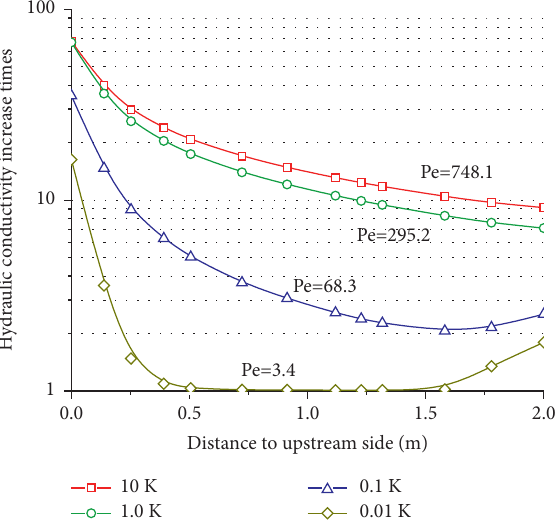
Figure 22: Hydraulic conductivity evolution curves of grout curtain with different initial hydraulic conductivities (0 . 01K , 0 . 1K , 1 . 0K , 10K , K � 1 . 0 × 10 − 8